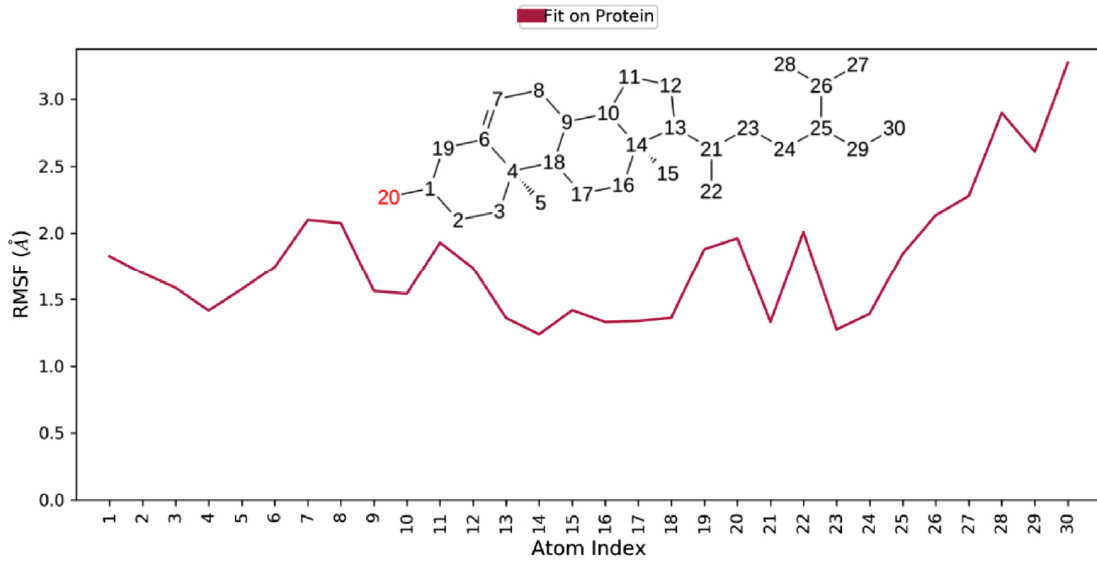
Figure 7. Histogram plot of beta-sitasterol in complex with 6IE9: X -axis depicts interactive amino acids and Y -axis reveals interaction fractions. (Gray color indicates Hydrophobic interactions, Blue color indicates water bridges and Green color indicates Hydrogen bonding) Table 5. Thermodynamic binding energy of Beta-sitasterol in complex with 6IE9. Title